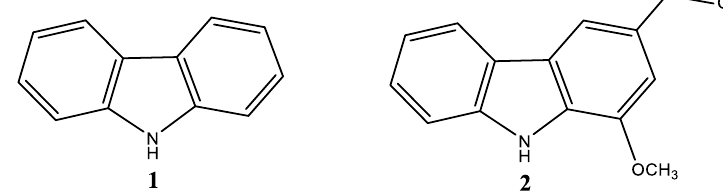
Figure 1. Structure of carbazole ( 1 ) and murrayanine ( 2 ).